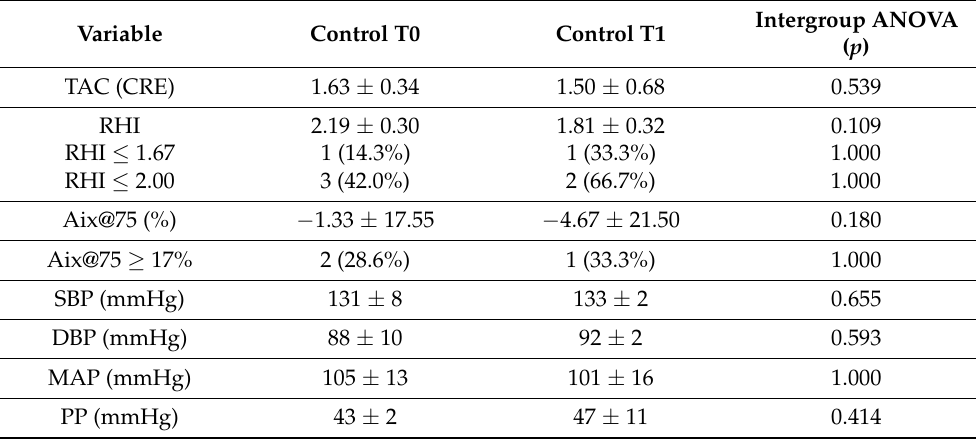
Figure 1. Schematic representation of the relationship between applanation tonometry performed by the SphygmoCor system and the TAC plasmatic values. (CRE: µ M Copper Reducing Equivalents; Aix: augmentation index). Table 5. Schematic representation of the comparison of the different variables studied, within the control group, at T0 and T1. # Standard deviation not reported; only one value analysed. Data are expressed as mean ± standard deviation (SD).